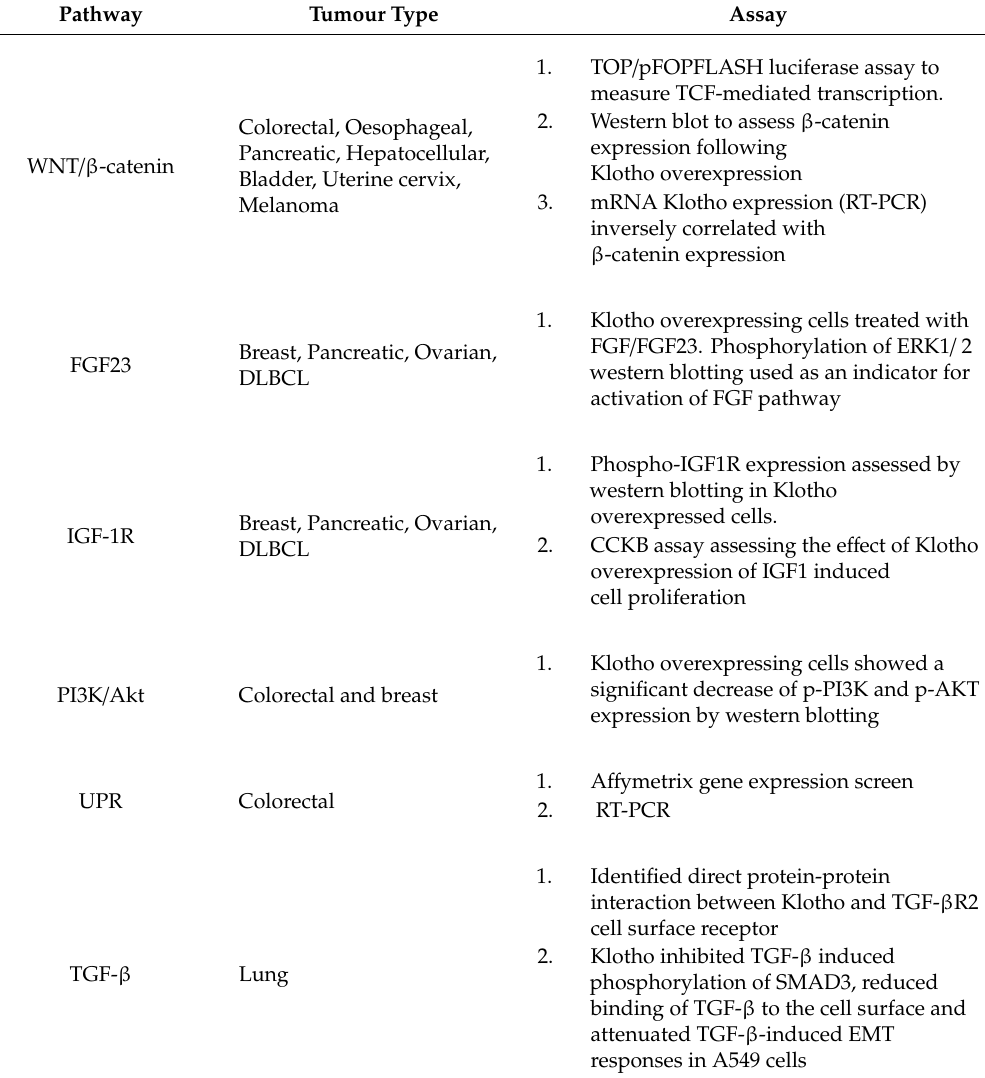
Table 2. Pathways that signal downstream of